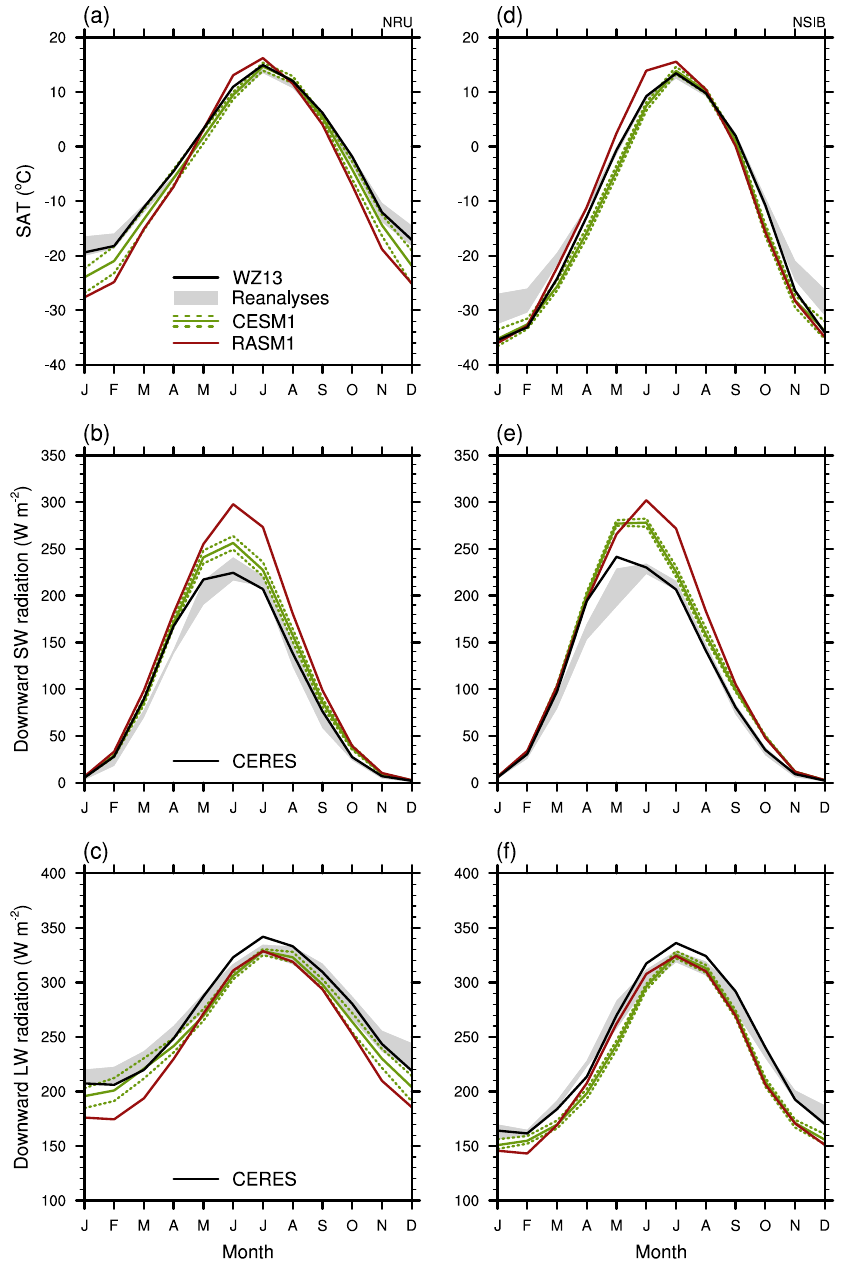
Figure 5. Regional mean of (a, d) 2m air temperatures (SAT) and (b, e) surface incident downward shortwave (SW) radiation and (c, f) longwave (LW) radiation for (a–c) the NRU region defined in the blue box in Fig. 6a and (d–f) for the NSIB region defined in the red box in Fig. 6a. Means are given for global datasets (Wang and Zeng, 2013, SAT, and CERES radiation; black), RASM1 (red), and CESM1 (green) along with the range in the three reanalyses (MERRA, ERA-Interim, and CFSR) indicated by the gray shading. The green dotted lines surrounding CESM1 indicate the ensemble maximum and minimum